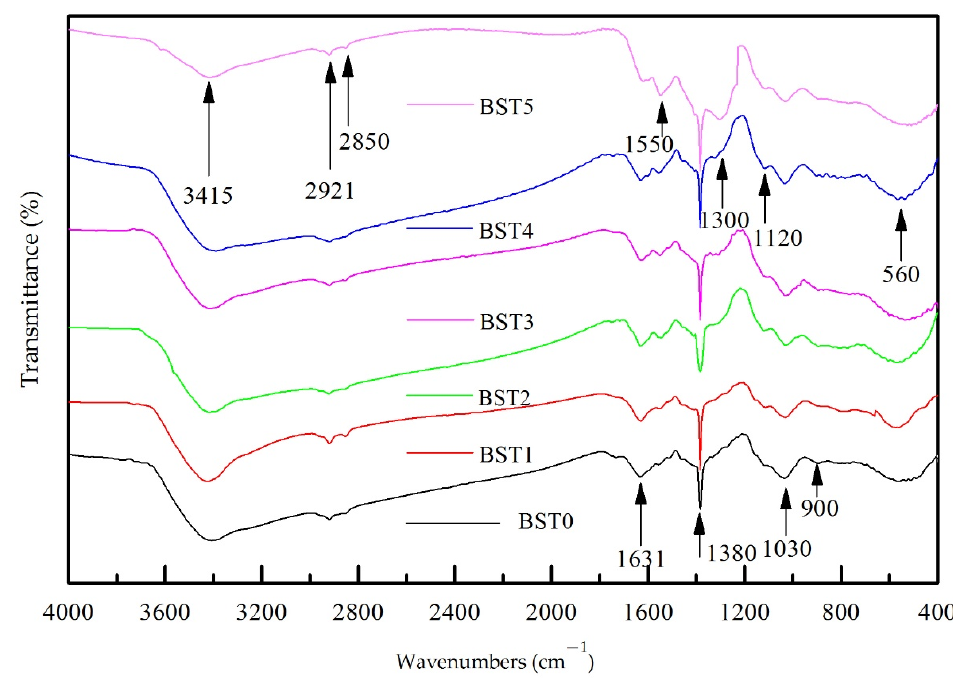
Figure 4. The FTIR spectrum of Si–Ti composite film prepared at different Bi-doped amounts.